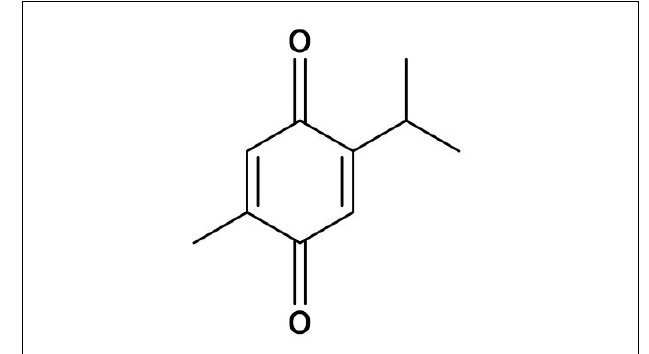
FIGURE 1 | Chemical structure of